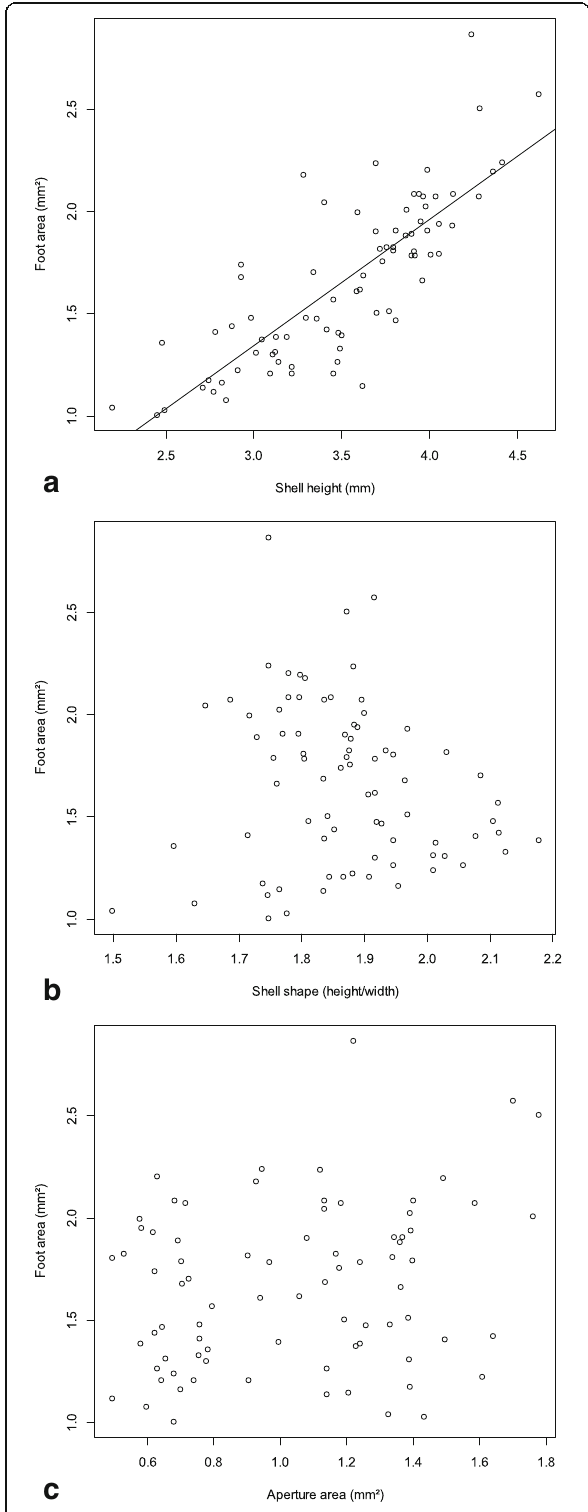
Fig. 7 Foot area of the P. antipodarum individuals used in the flow tank experiment plotted against shell height ( a ), shell shape ( b ) and aperture area ( c )